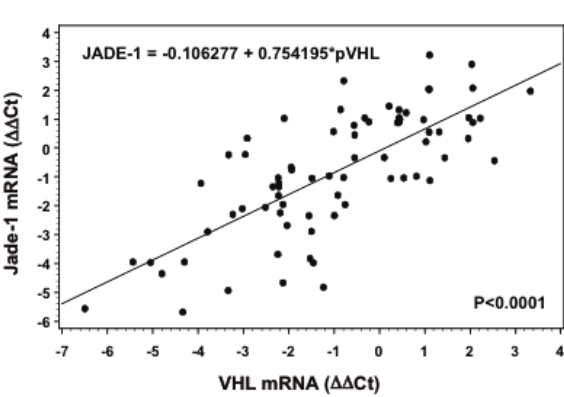
Figure 2: The positive correlation between VHL and Jade-1 expres- sion in 75 RCC samples was determined using Spearman’s correla- tion analysis